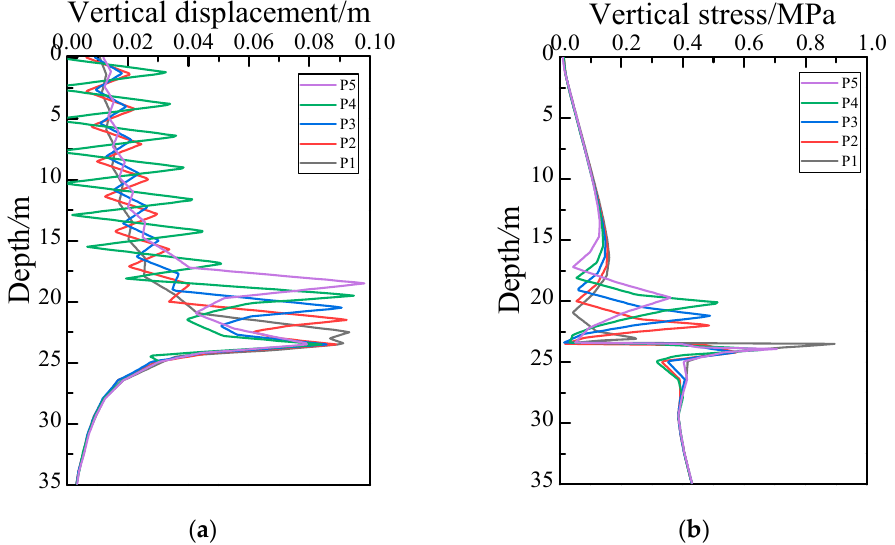
Figure 15. Variation of displacement and stress with depth. ( a ) Indentation displacement–depth curves; ( b ) Stress–depth curves.